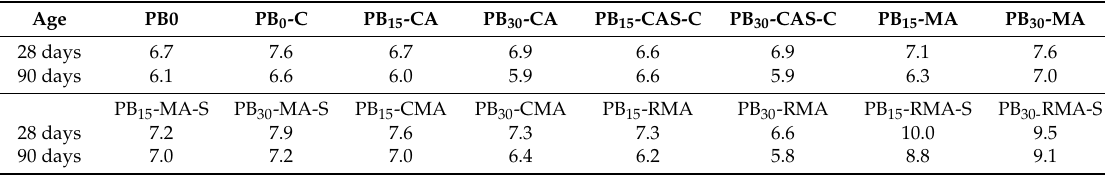
Table 9. Results of water absorption (%), of paving blocks, as a function of the aggregate type, dosaging method (see Table 5 for nomenclature), and time.